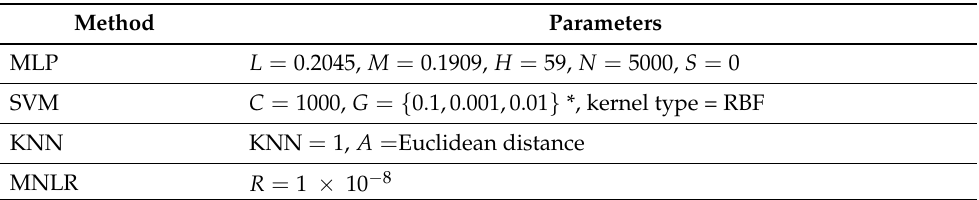
Table 3. First experiment: classifiers’